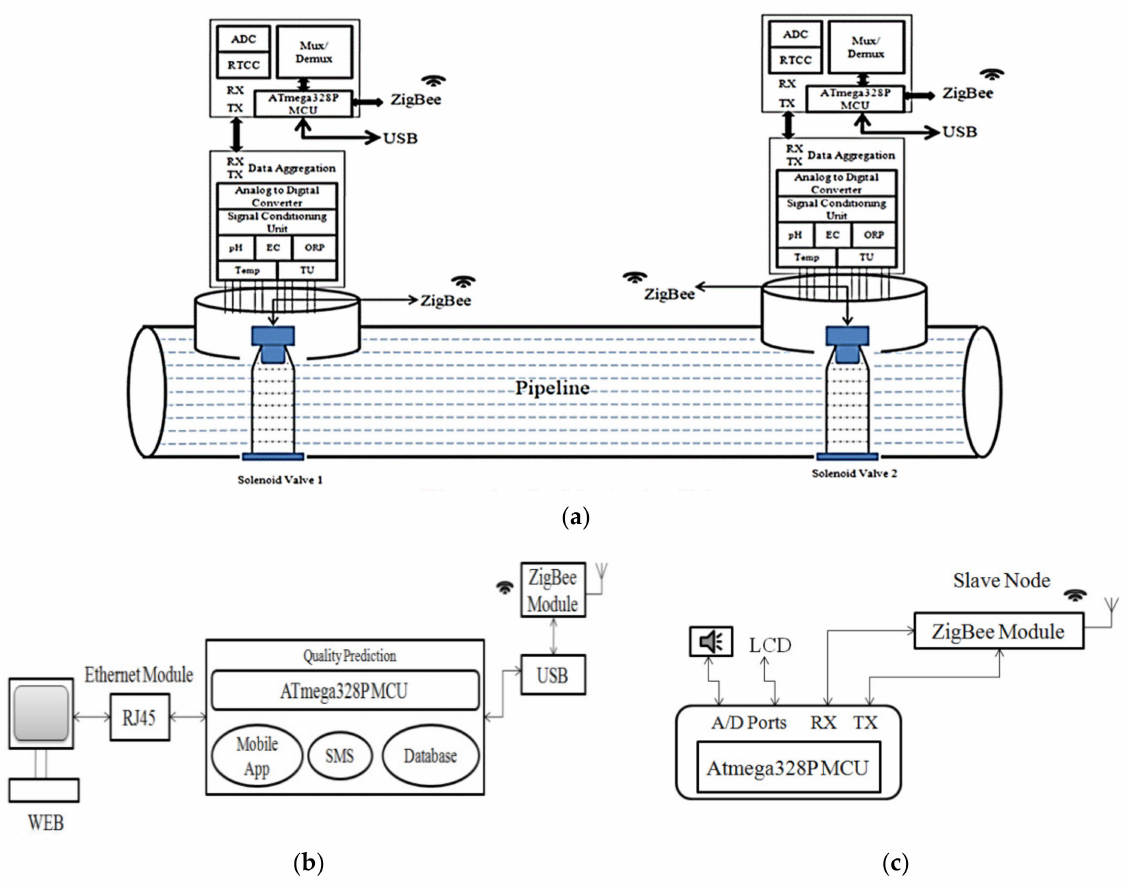
Figure 8. Architecture of the system proposed in [68]. ( a ) Water quality monitoring unit. ( b ) Central processing unit. ( c ) Notification unit for administration